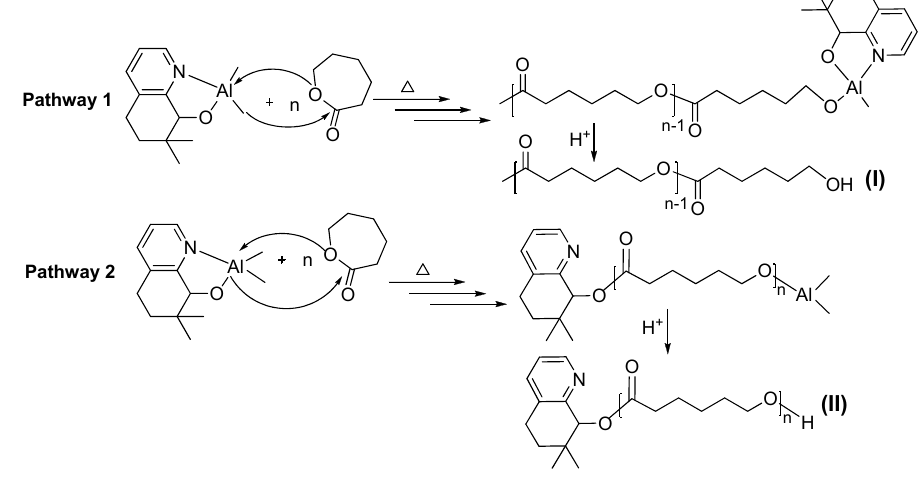
Scheme 2. Possible mechanistic pathways for the ring opening polymerization of ε -CL using C1 .